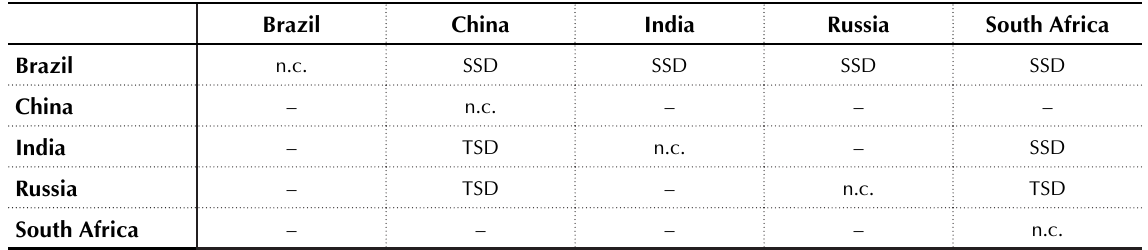
Table 1. Dominance relations between the strategies in different